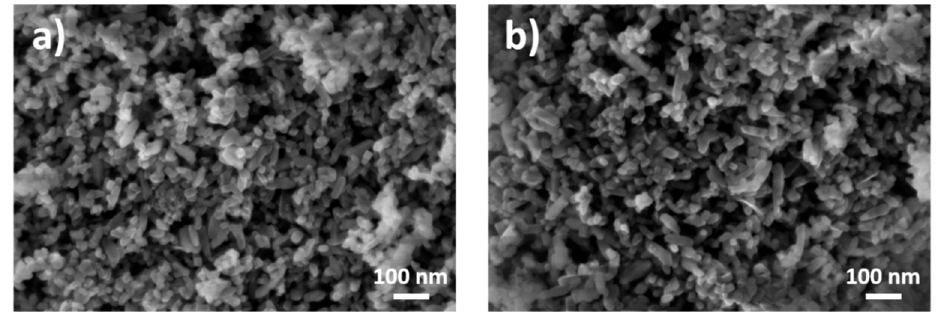
Figure 2. Titanium dioxide nanoparticles imaged by SEM with a secondary electron InLens detector at 5 kV beam voltage: ( a ) JRCNM62001a and ( b ) JRCNM62002a. The samples have been prepared as dry powder on an aluminum sample